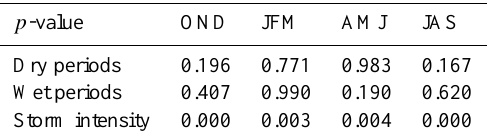
P-value results of the Kolmogorov-Smirnov goodness-of-fit test for the assessment of distributional agreement between the reference observations and the PRP-modelled rainfall after the bias correc-